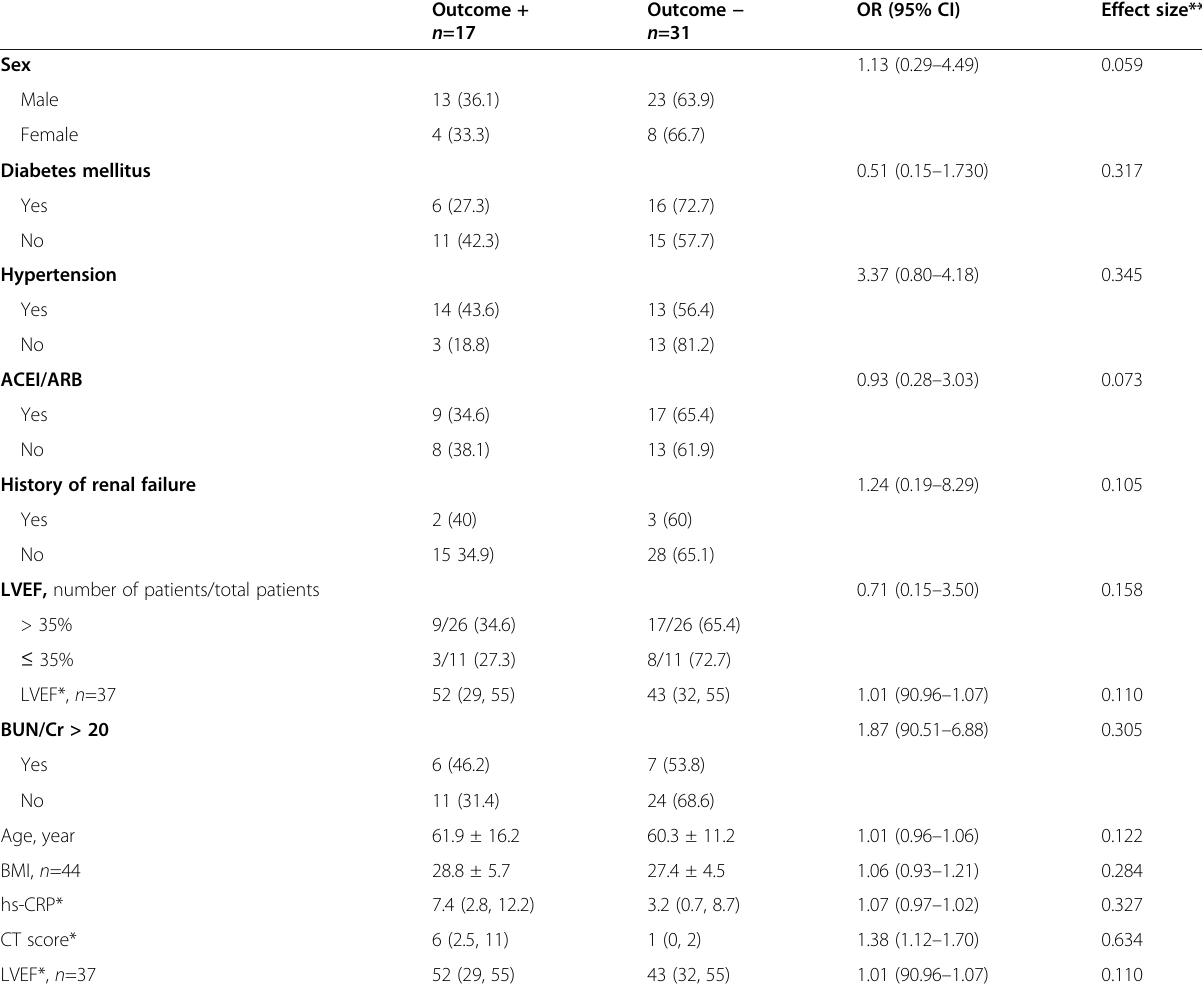
Table 2 Univariate relationships between the demographic and clinical characteristics and the outcome